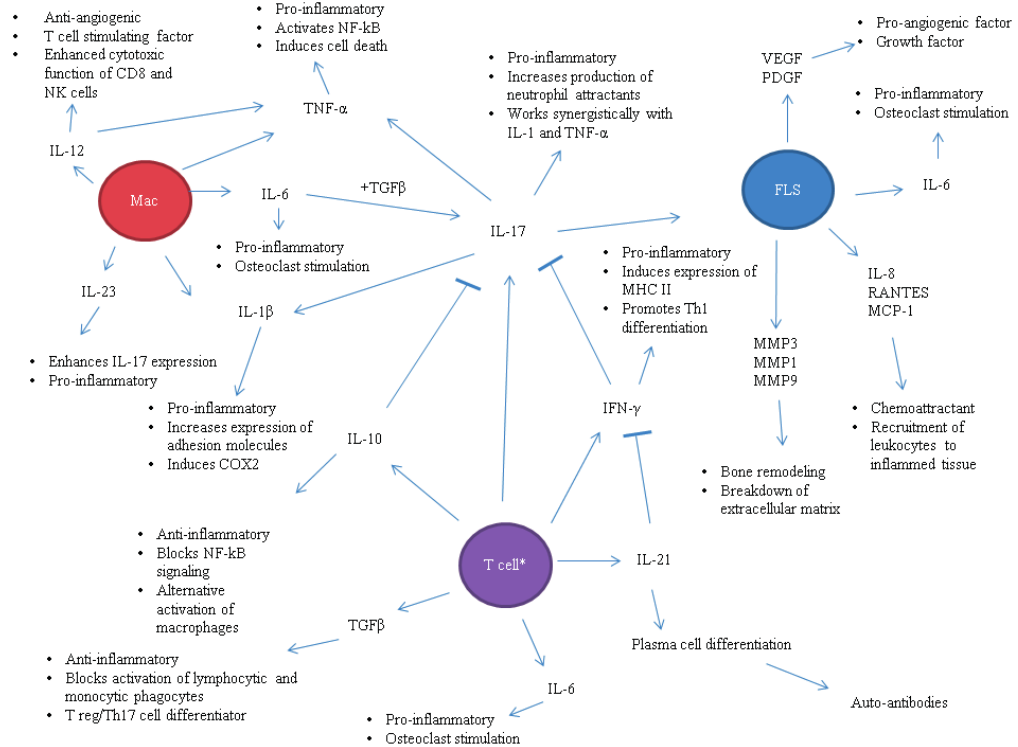
Figure 1. The roles of cytokines in arthritis pathogenesis. The cytokine environment in the joints and the draining lymphoid tissue in rheumatoid arthritis is rather complex. There are multiple cell types that are present and each secretes a panel of pro-/anti-inflammatory cytokines, chemokines, or other inflammatory mediators. Each cytokine has its own role in either promoting an immune response or regulating the immune response. Moreover, one cytokine can have more than one function, known as pleiotropy, or have duality of action (both pro- and anti-inflammatory properties). Furthermore, there is redundancy meaning that there are overlapping characteristics between different cytokines (e.g., IL-6 and IL-17 being pro-inflammatory). Depending on the proportion of cell types present within the joints and the type of immune stimuli that they are exposed to, the overall milieu in the tissue is predominantly pro-inflammatory or anti-inflammatory. COX2, cyclooxygenase type 2; FLS, fibroblast-like synoviocyte; IL, interleukin; Mac, macrophage; MCP-1, monocyte chemoattractant protein 1; MHCII, major histocompatability complex class II; MMP, matrix metalloprotease; PDGF, platelet derived growth factor; RANTES, regulated on activation, normal T cell expressed and secreted; TGF β , transforming growth factor β ; Treg, T regulatory cell; VEGF, vascular endothelial growth factor. * Asterisk within the T cell denotes multiple subtypes: Th1, Th17, or